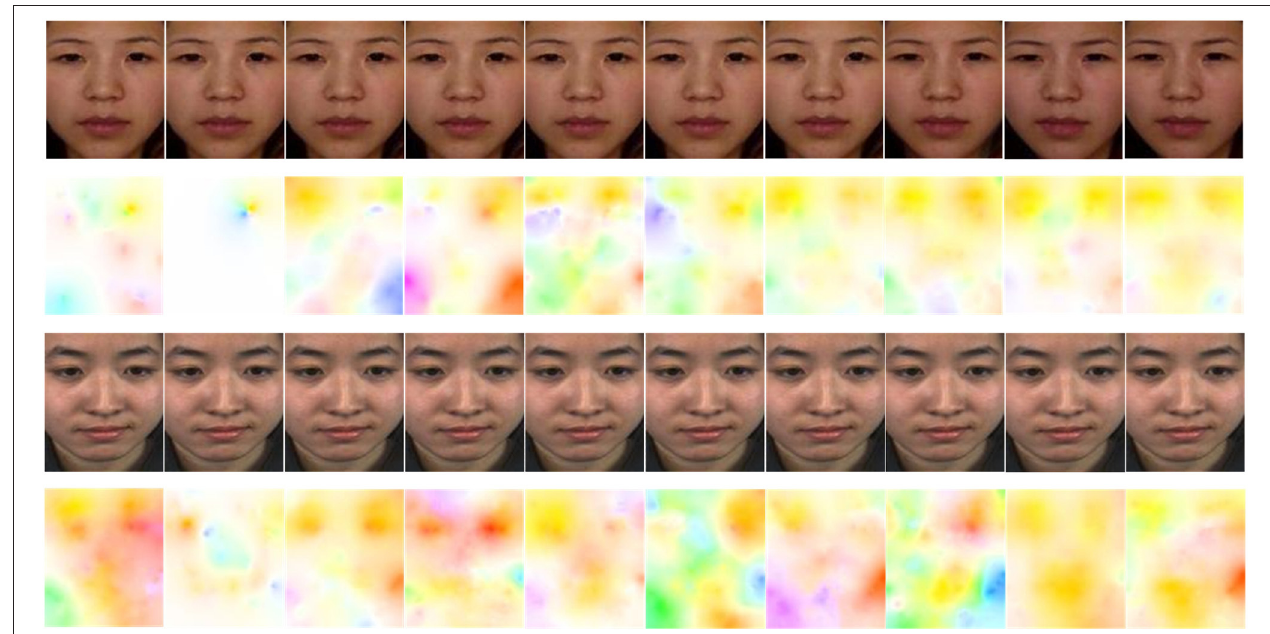
FIGURE 2 | Two samples are pre-processed and estimated optical fields. The first row and third row micro-expression sequence are from CASMEI (subject 01, EP12_3, frames: 45–54) and CASMEII (subject 17, EP05_02, frames: 53–62) database, respectively. The former one expressed a surprise emotion and the latter expressed a positive emotion (happiness). Row 2 and 4 is the optical flow sequence that computed from their above line, respectively.